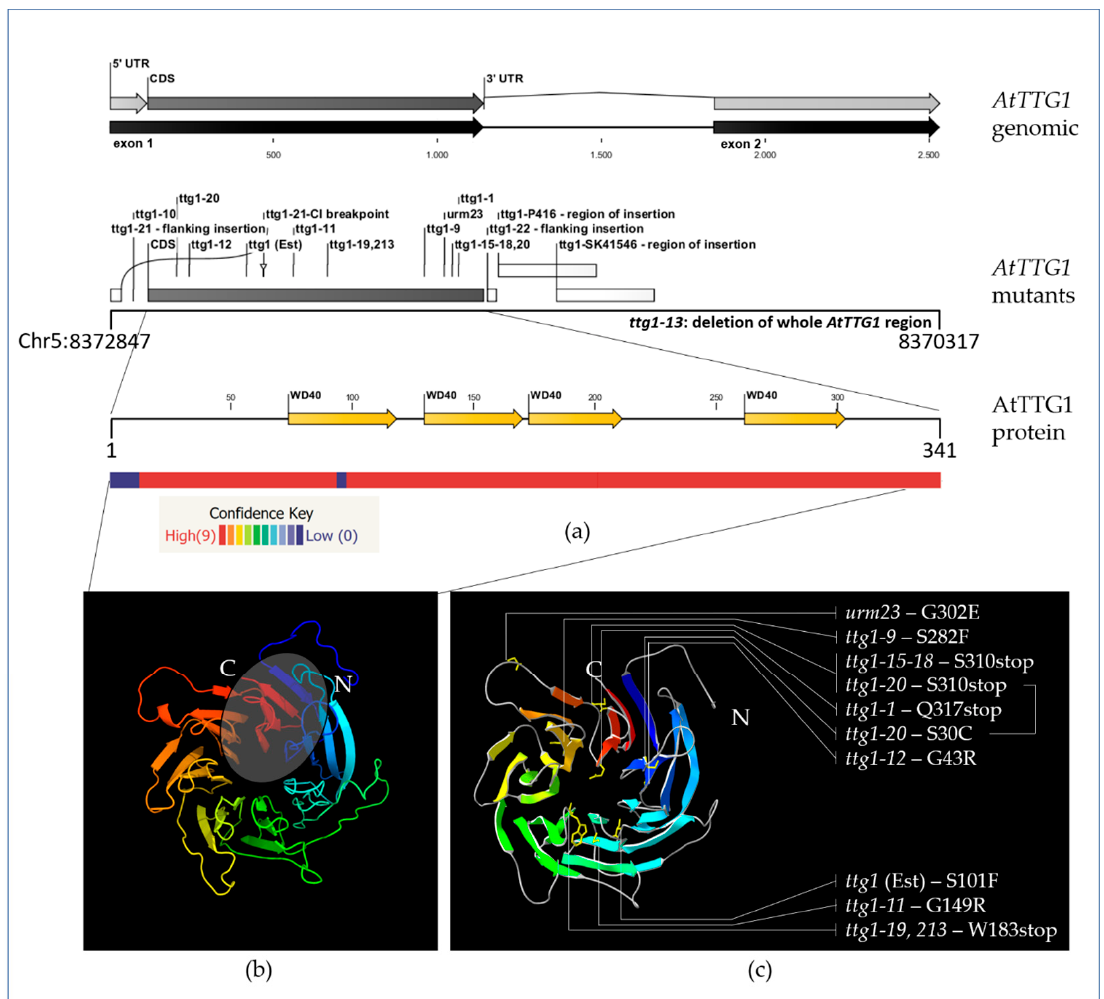
Figure 3. ( a ) AtTTG1 gene structure, mutants and protein domains. The AtTTG1 gene structure was retrieved from TAIR [105]. Exons, introns, 5 ′ and 3 ′ UTR, mutants and protein domains were visualized using CLC DNA workbench 5.3.1 (CLC bio, Aarhus, Denmark). Please note that the intron is not part of the 3 ′ UTR, which comprises the last nucleotide of exon 1 and the full exon 2. When searching databases for domains and repeats of AtTTG1, the resulting number, positioning and confidence for the detected WD40 repeats are diverse (e.g., SMART, PROSITE) [106–109]. Shown here is the annotation provided by UniProt. The colored bar below the protein sequence indicates the confidence of the Phyr2 model shown in ( b ) along the protein [110]. ( b , c ) AtTTG1 tertiary structure. The AtTTG1 protein tertiary structure was modeled using ( b ) Phyre2 or ( c ) loaded into SwissProt PdbViewer v.4.1.0 for marking the amino acids that are mutated or changed to a stop codon in the mutants [110,111]. Both ( b , c ) underline a part of the β -sheet structure, in particular the relevance of the C-terminus of AtTTG1 for the tertiary structure (highlighted by an ellipse in ( b )). For the list of mutants and respective references, please refer to Table 1. CDS: coding DNA sequence, UTR: untranslated region.